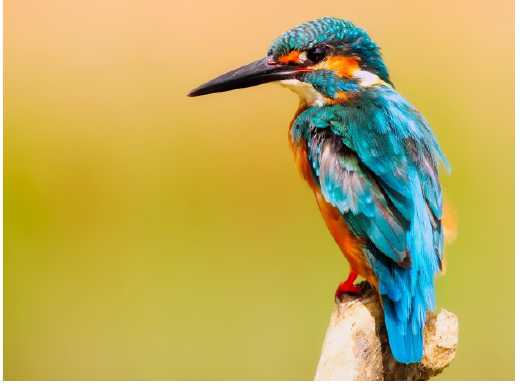
Figure 5.1 Monument Image